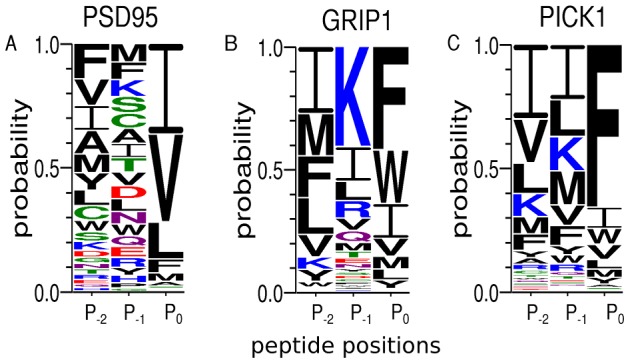
Peptide-binding specificity profiles from computational peptide screening.We applied our peptide screening method to the proteins (A) PSD95, (B) GRIP1, and (C) PICK1 with the peptides KKE-, ATVRT- and ES-, respectively, where  indicates a variable amino acid position. As illustrated in Figure 1, the obtained probability distributions  represent the peptide-binding specificities of the proteins. Shown are “one-dimensional” specificity profiles for the 3 variable peptide positions, illustrated as weblogos [48]. At a given peptide position i, the letter height is determined by , i.e., the probability of observing the amino acid type  at position i. The color scheme is as follows: hydrophobic (A, V, L, I, P, W, F, M, Y) black, polar (G, S, T, C) green, neutral (Q, N) purple, basic (K, R, H) blue, and acidic (D, E) red.